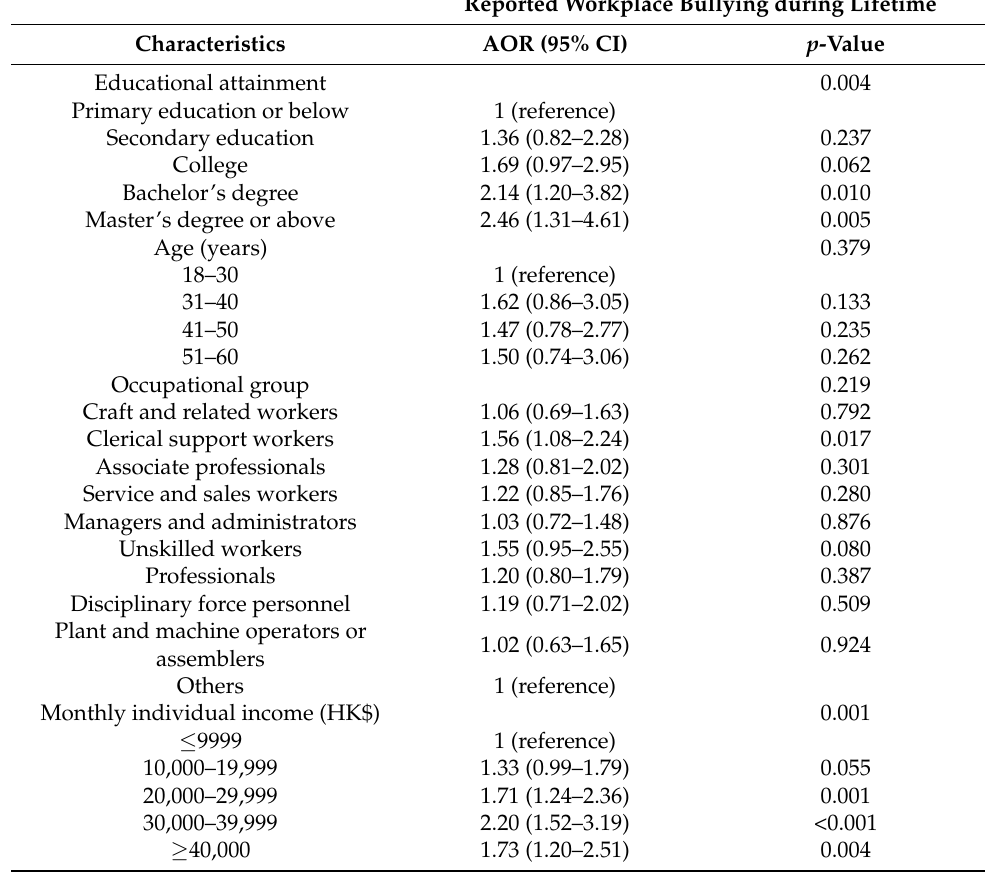
Table 4. Adjusted odds ratios (AOR) and 95% confidence intervals (95% CI) of workplace bullying during lifetime by risk